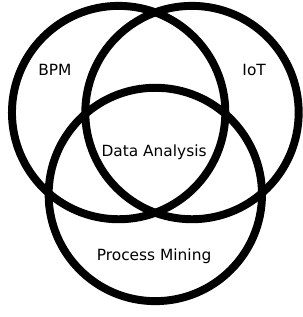
Figure 1. Related